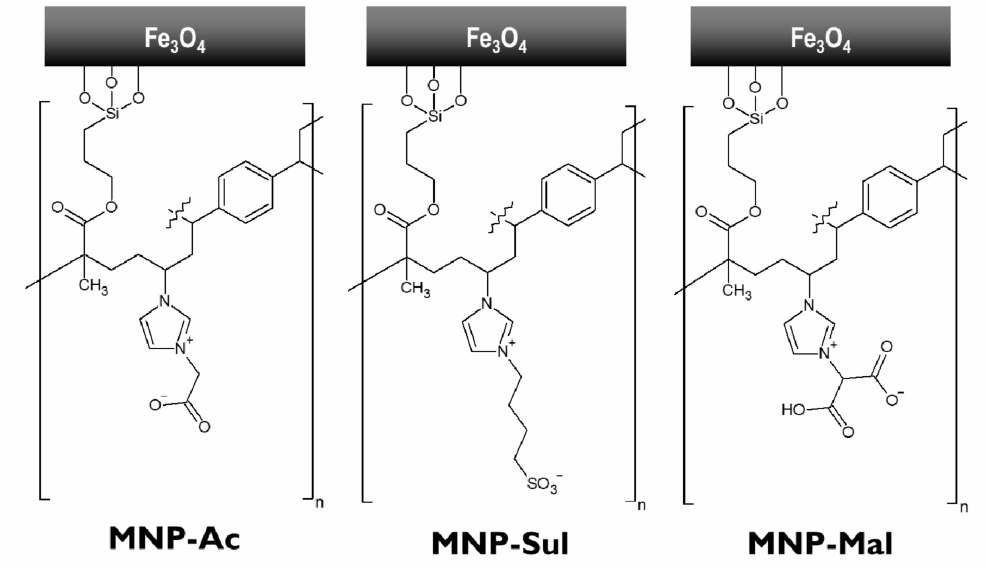
Figure 2. Schematic structures of magnetic nanoparticles coated with crosslinked zwitterionic poly(ionic liquid)s obtained in this